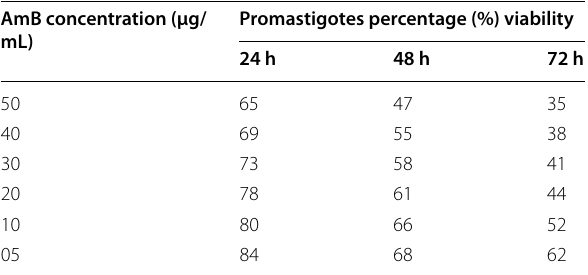
Table 2 Promastigotes viability percentage after treatment with conventional AmB drug